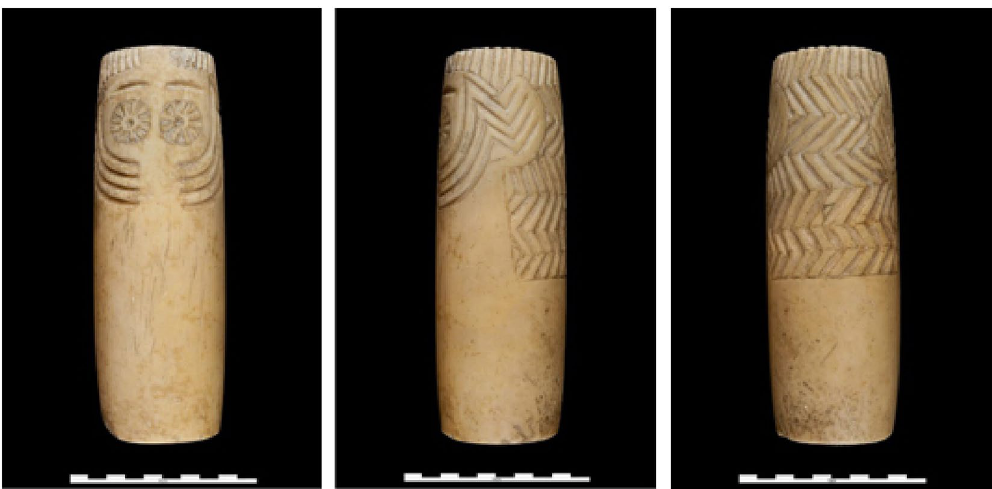
Figure 4. Oculated idol carved in alabaster known as Ídolo de Extremadura (unknown provenance, MAN, Madrid, 20572), and perhaps modelled after a long-eared owl. Tufts were carved on the sides and back of the head. The zigzagging pattern in the back, interpreted as long hair, may also be described as the camouflaged plumage pattern in the dorsal area of an